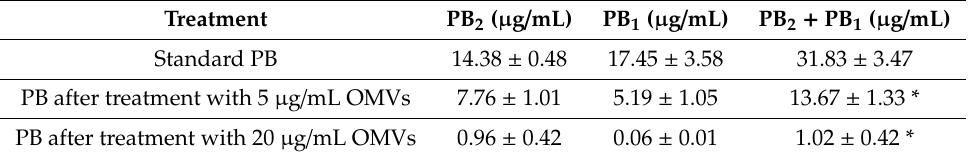
Table 2. Magnitude of PB sequestration on M. catarrhalis